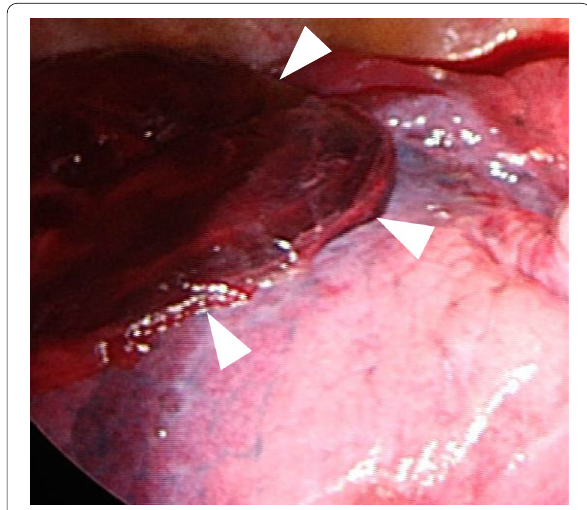
Fig. 2 The pleural surface of the lower lobe was found to be torn and covered with a blood clot (arrows) during the